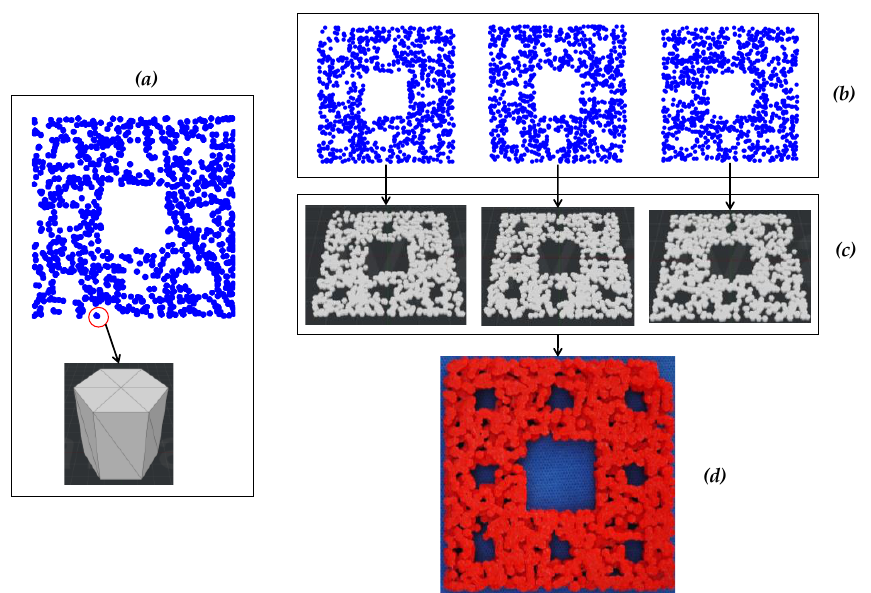
Figure 15. Prismoid-based solid modeling of IFS fractal generated point clouds and a 3D printed porous structure: ( a ) modeling concept; ( b ) three different point clouds generated by the IFS Algorithm; ( c ) prismoid-based solid models of the respective point clouds; and ( d ) 3D-printed porous structure of combining solid models in ( c ).